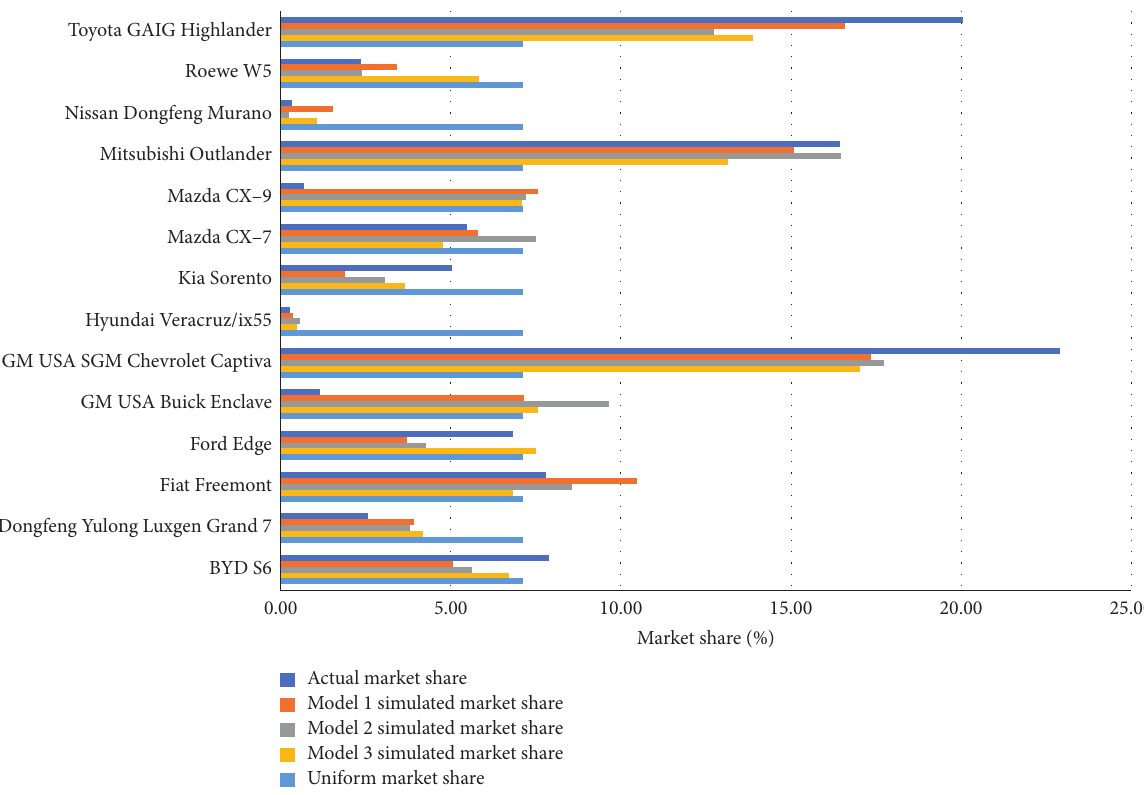
Figure 8: Valued ERGM prediction of 2013 crossover SUVs market share aligns with the true market